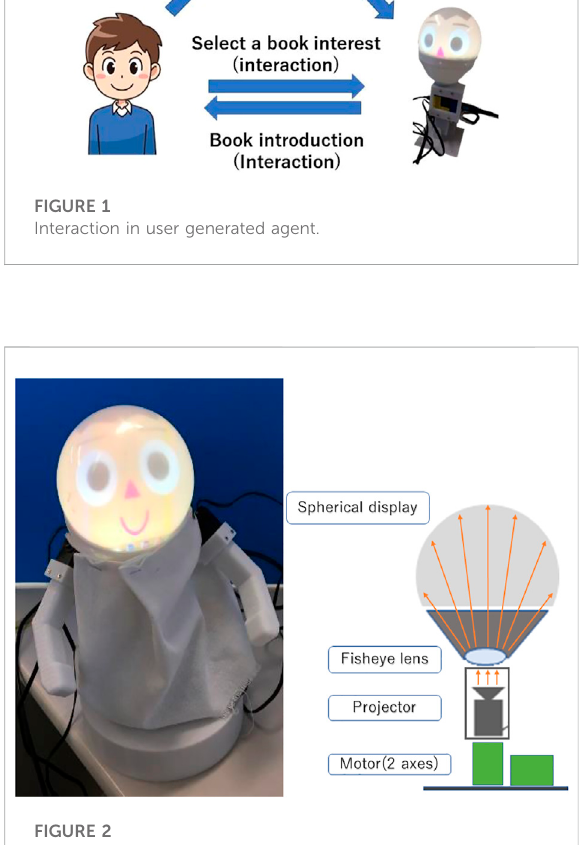
FIGURE 2 Appearance of UGA (left) and illustration of face